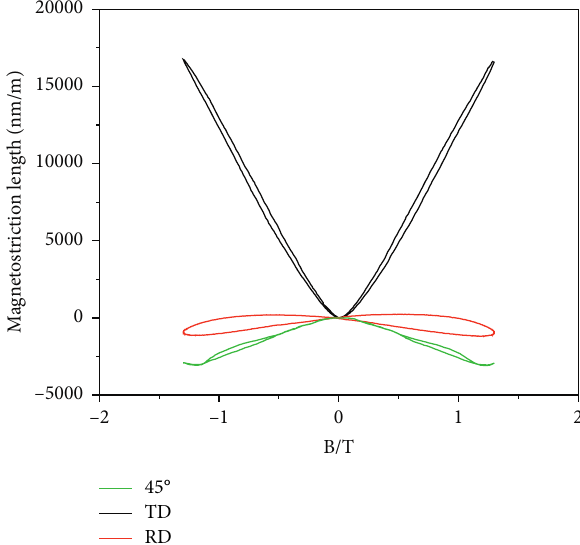
Figure 10: Butterfly curves of grain-oriented SSS under sinusoidal excitation of 1.3 T magnetic density in different directions.